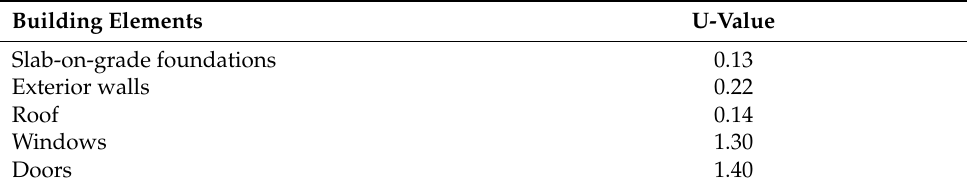
Table 2. U-values (W/m 2 .K) for